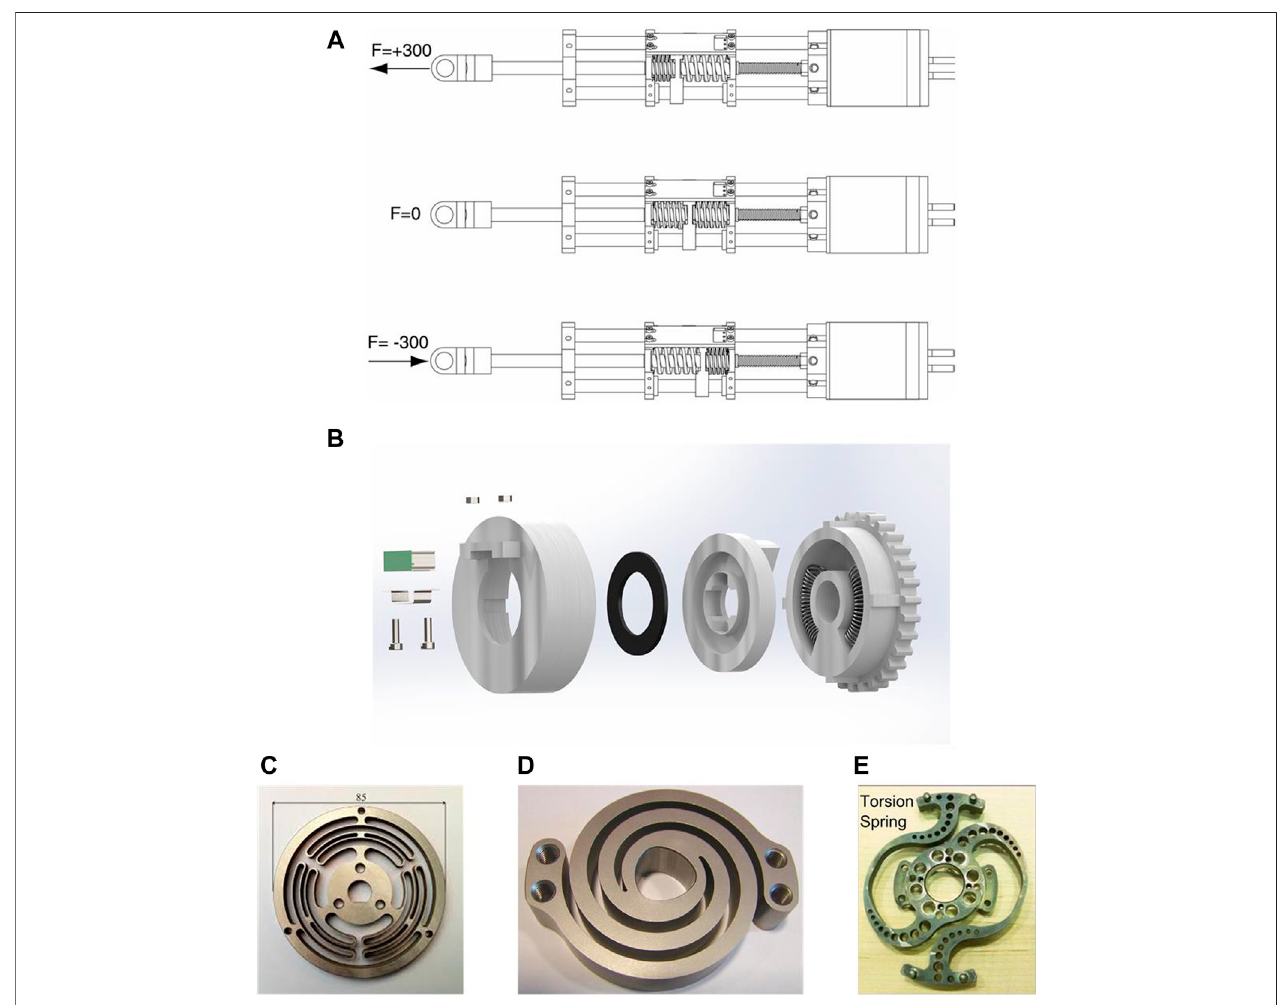
FIGURE 2 | Different designs of the elastic element (A) series elastic actuator SEA23-23 from Yobotics (Pratt et al., 1997, 2002) (B) series elastic actuator from Serpens robot (San fi lippo et al., 2019a) (C) a torsional elastic element of wearable robots for knee assistance (Carpino et al., 2012) (D) LOPES ′ spring (Lagoda et al., 2010) (E) NASA Valkyrie ’ s spring (Paine et al., 2015; Radford et al., 2015).